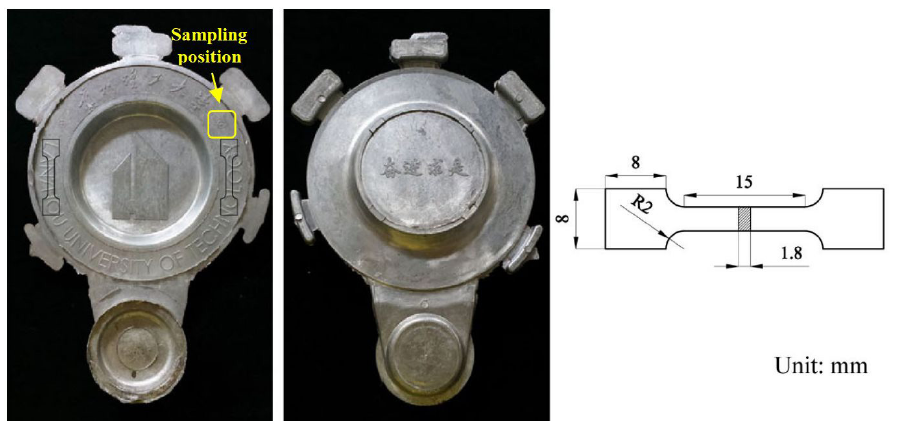
Figure 2. The die casting component and the sampling